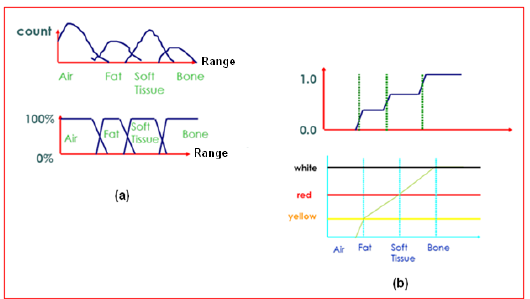
Figure 1. (a) Overlapping classification (b) Imprecise transfer function design.